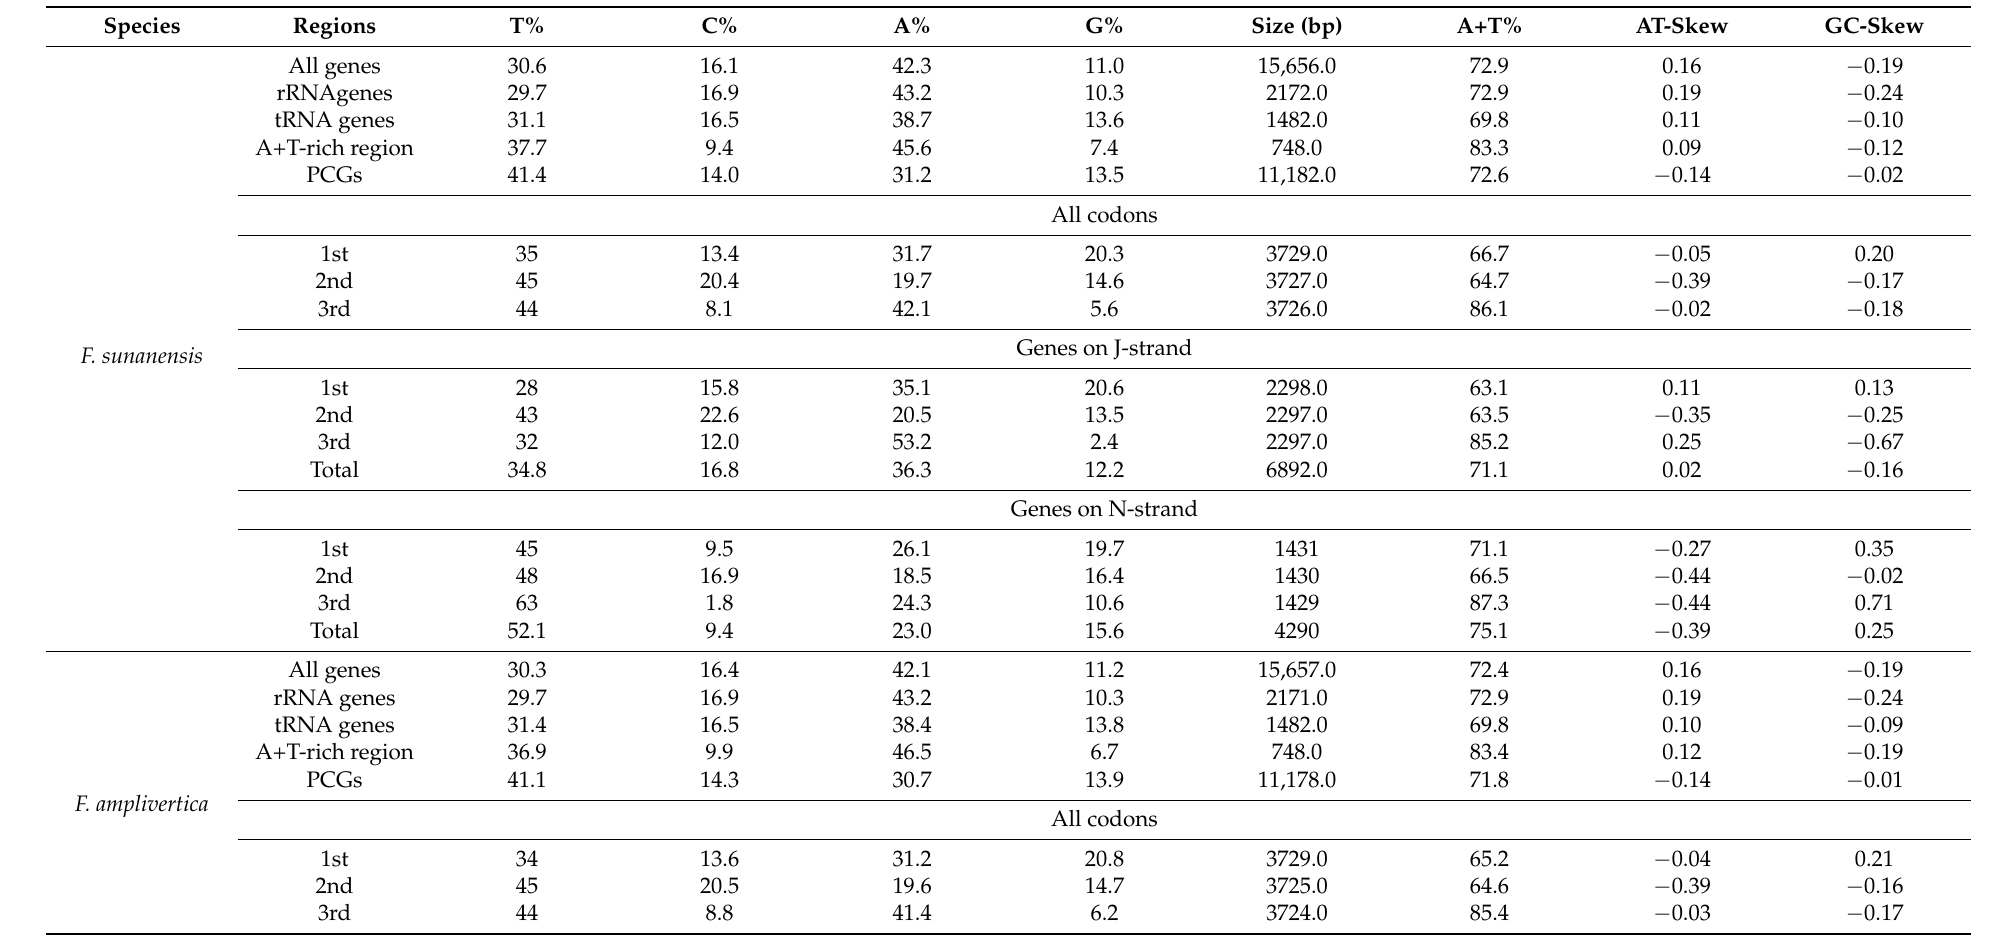
Table 4. Nucleotide composition features of the 5 species of Filchnerella